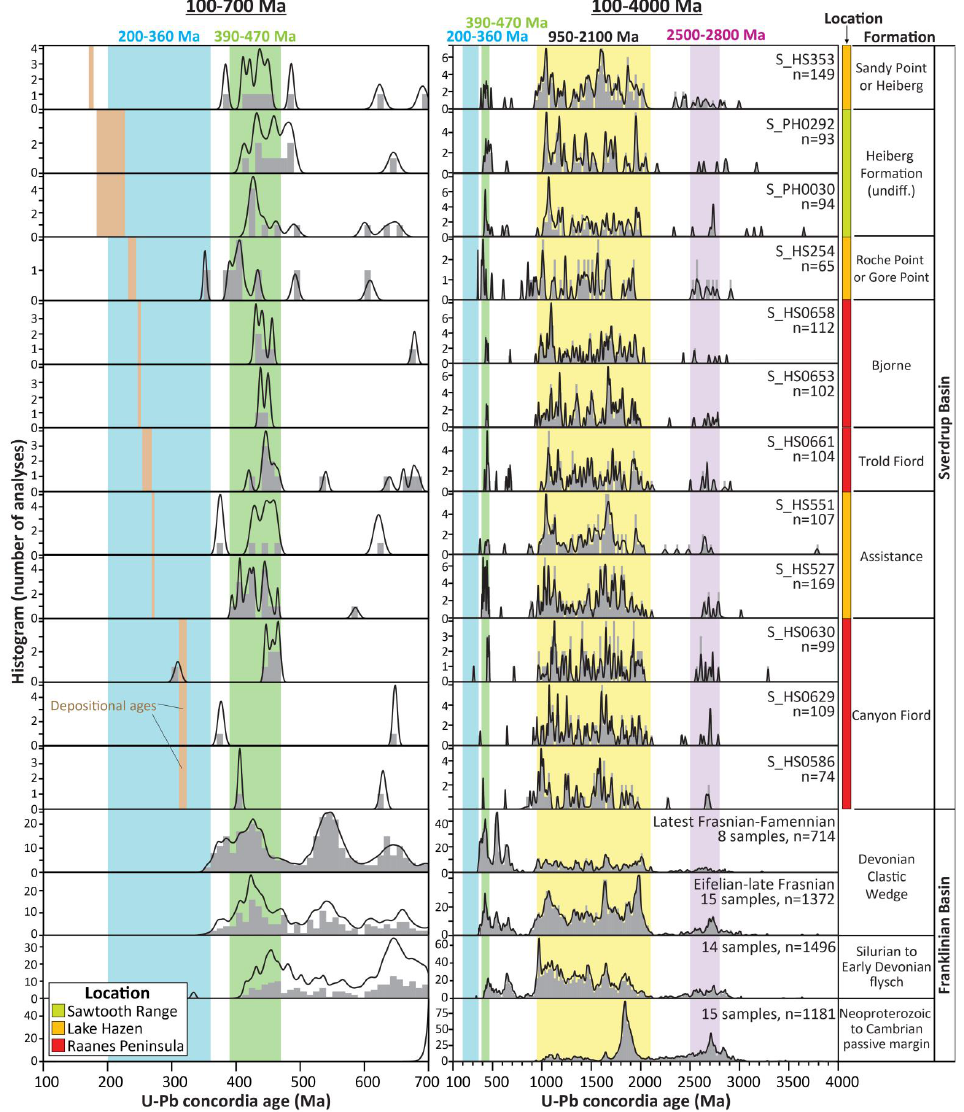
Figure 9. Combined probability density plots and histograms showing the detrital zircon U–Pb age data obtained from Late Carboniferous to Jurassic samples analysed from the southern margin of the Sverdrup Basin. Only data that are <10% discordant are shown. Approximate depositional ages shown in the left-hand panel (brown bars) are from Figure 2 with stratigraphic ranges referenced to Cohen et al. [70]. The histogram bin width is 10 and 20 Ma in the left- and right-hand columns, respectively. Published data from the Franklinian Basin succession are from Anfinson et al. [42,43], Beranek et al. [47,58], Hadlari et al. [57], and Malone et al. [50].